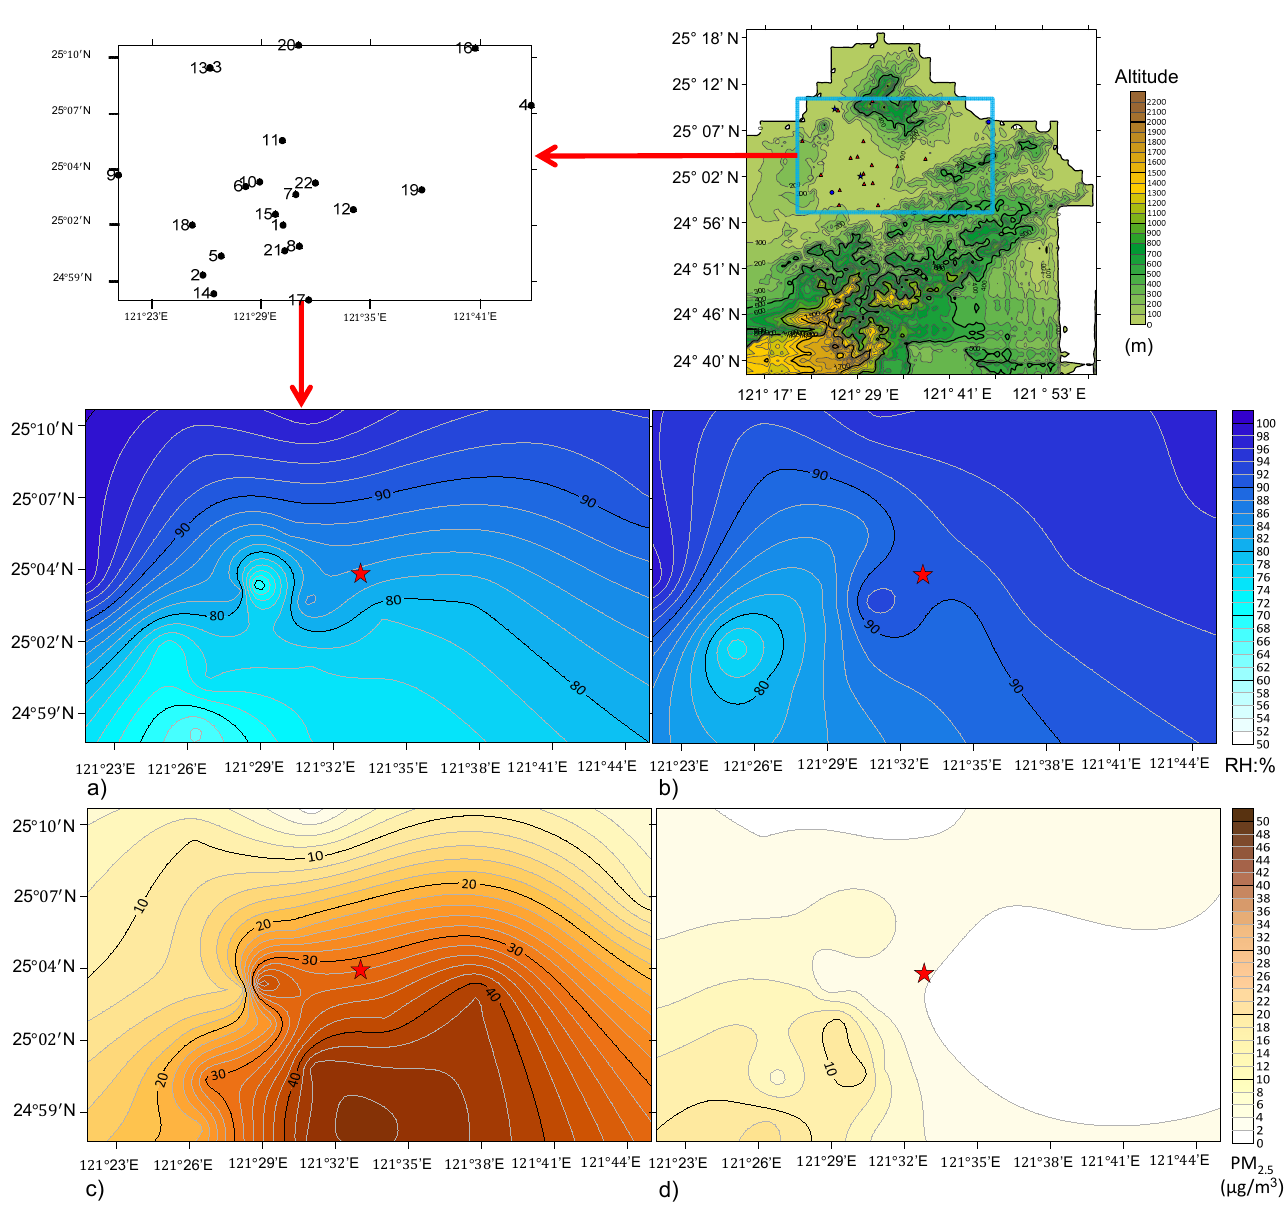
Figure 6. Comparison of the distributions of relative humidity (RH) and PM 2.5 concentrations between the two cases when the synoptic weather pattern was type I and the urban heat island effect was greater than 0 °C: ( a , c ) mean PM 2.5 concentration was 25.9 µg/m 3 , and mean RH was 86.3% on 5 January 2019 14:00 LST; ( b , d ) mean PM 2.5 concentration was 5.1 µg/m 3 , and mean RH was 86.3% on 22 February 2019 14:00 LST. The red star symbol indicates Songsang International Airport (121° 33 ′ 09 ″ E, 25° 04 ′ 11 ″ N).